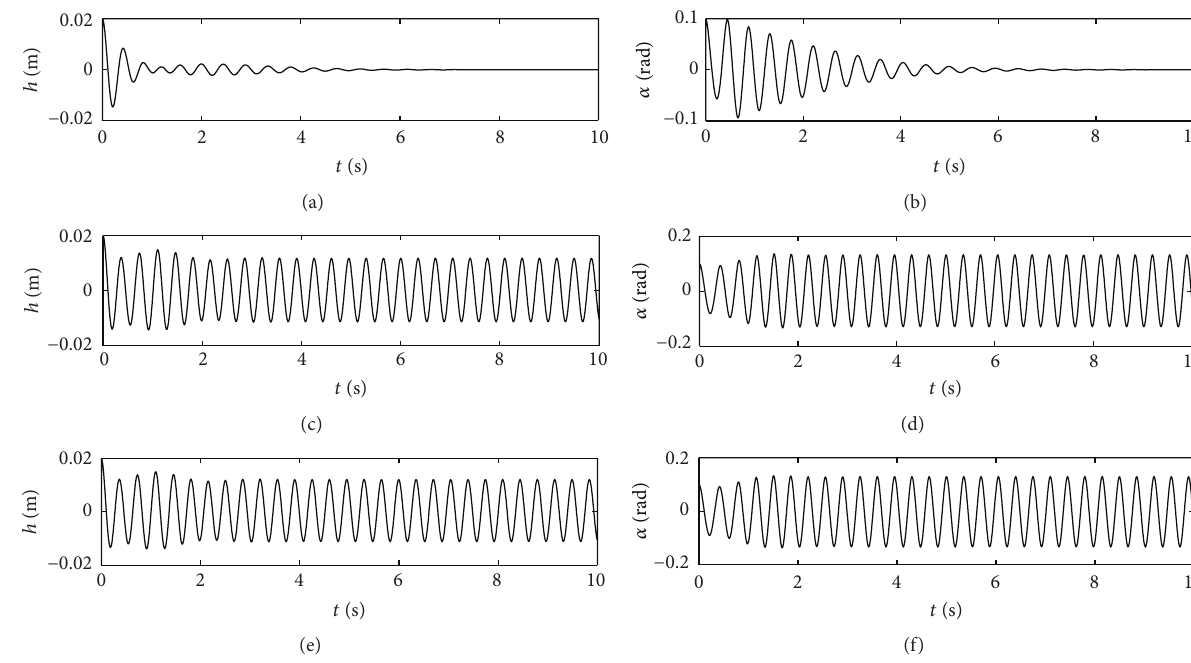
Figure 3: Open-loop LCO in the open-loop system: (a), (b) ℎ (m) and 𝛼 (rad) under triangular gust for 𝑤 0 = 0.7 , 𝑈 = 10 m / s; (c), (d) ℎ (m) and 𝛼 (rad) under graded gust for 𝑤 0 = 0.07 , 𝑈 = 16 m / s; (e), (f) ℎ (m) and 𝛼 (rad) under sinusoidal gust for 𝑤 0 = 0.07 , 𝑈 = 16 m / s.